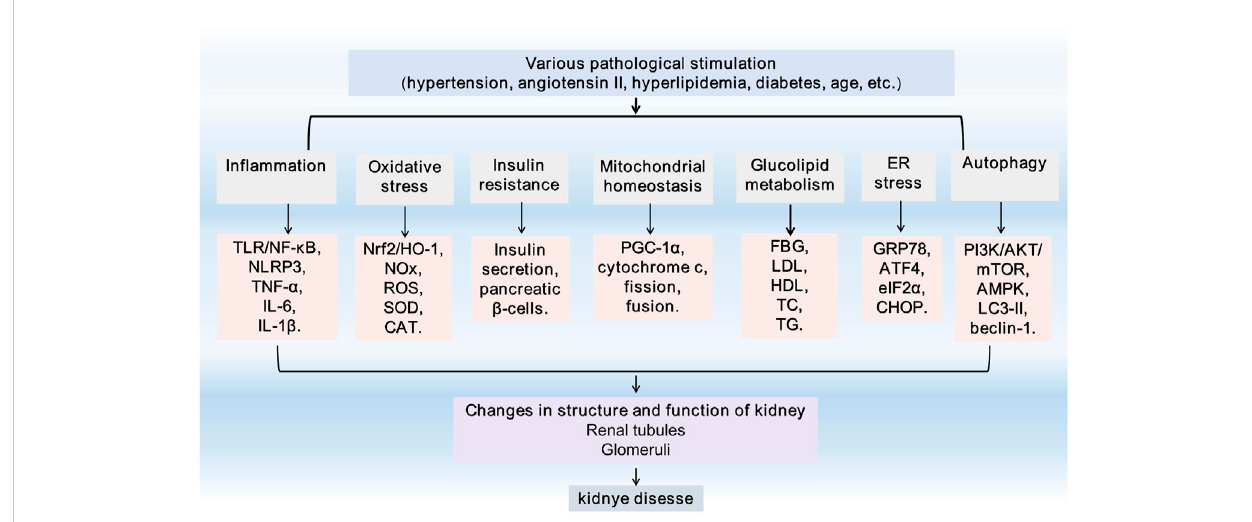
FIGURE 1 General feature of kidney injury. TLR4, Toll-like receptor 4; NF- κ B, Nuclear factor-kappaB; NLRP3, Nucleotide leucine-rich polypeptide 3; IL-1, interleukin-1; TNF- α , tumor necrosis factor alpha; Nrf2, nuclear factor erythroid 2-related factor 2; HO-1, heme oxygenase-1; NADPH, Nicotinamide adenine dinucleotide phosphate; NOX, NADPH oxidase; ROS, reactive oxygen species; SOD, superoxide dismutase; CAT, catalase; PGC-1 α , Peroxisome proliferator-activated receptor γ coactivator-1 α ; FBG, fasting blood glucose; TG,triglyceride; TC, total cholesterol; LDL, low-density lipoprotein; HDL,high-densitylipoprotein;GRP78,glucose-regulatedprotein78;ATF4,activating transcriptionfactor4;eIF2 α ,eukaryoticinitiationfactor-2 α ;CHOP, C/EBP homologous protein; PI3K, phosphatidylinositol 3-kinase; AKT, protein kinase B; mTOR, mammalian target of rapamycin; AMPK, adenosine monophosphate-activated protein kinase; LC3, microtubule-associated protein light chain 3; ER, endoplasmic